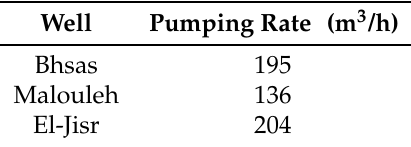
Table 2. Pumping rate of public